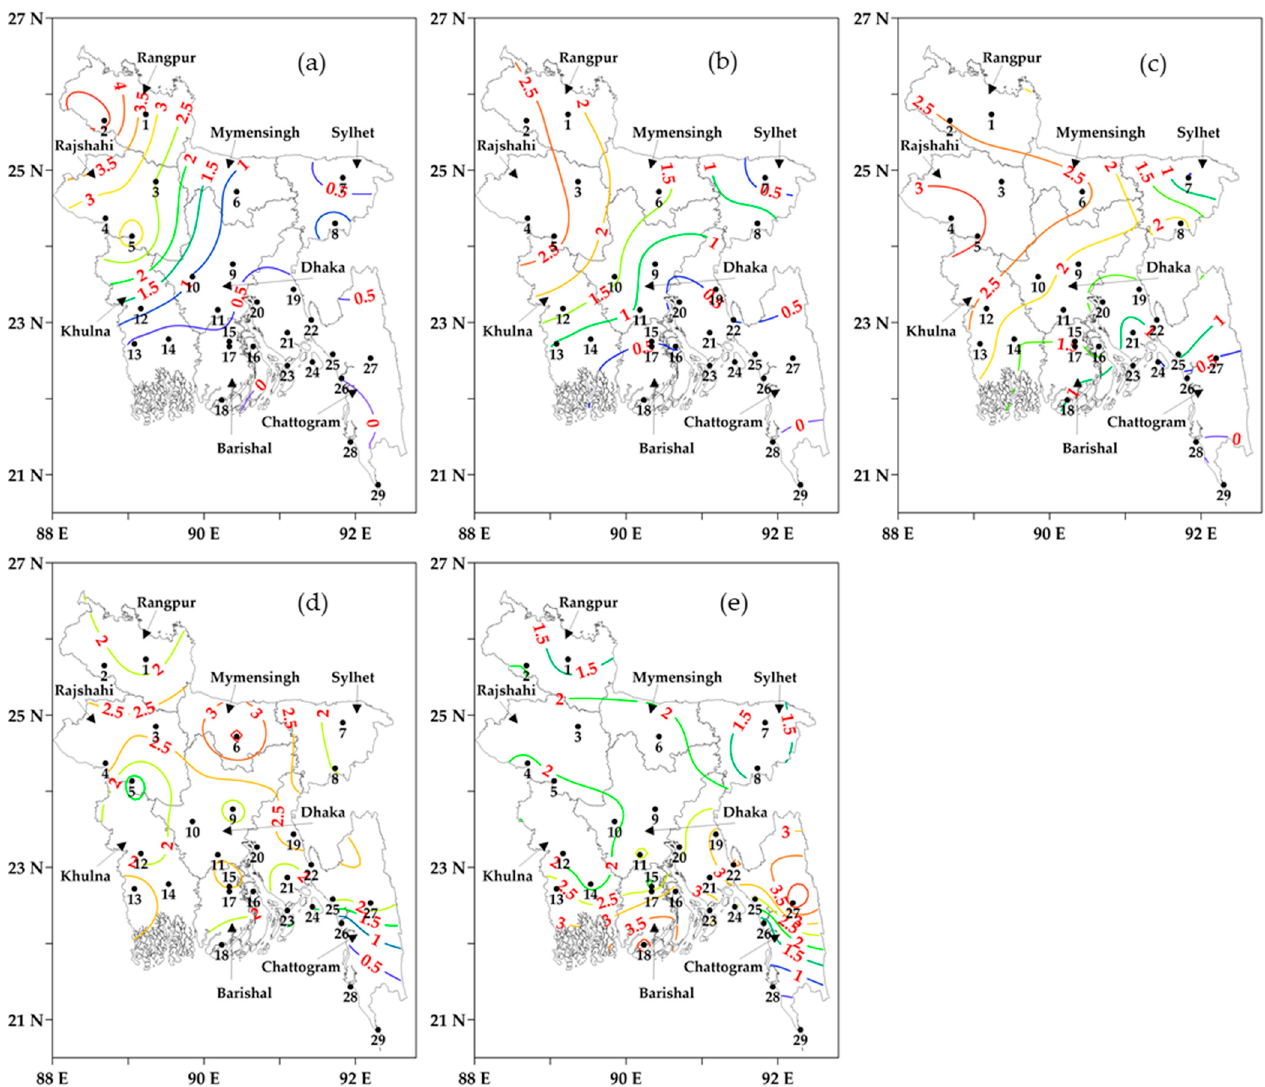
Figure 5. The categorization of average cold days (in coloured contour lines with values) using the threshold of average temperatures as: ( a ) Extreme, ( b ) Severe, ( c ) Very, ( d ) Moderate, and ( e ) Mild during the winters of 2000 ‒ 2001 to 2020 ‒ 2021. The black numbers are the IDs of meteorological stations.